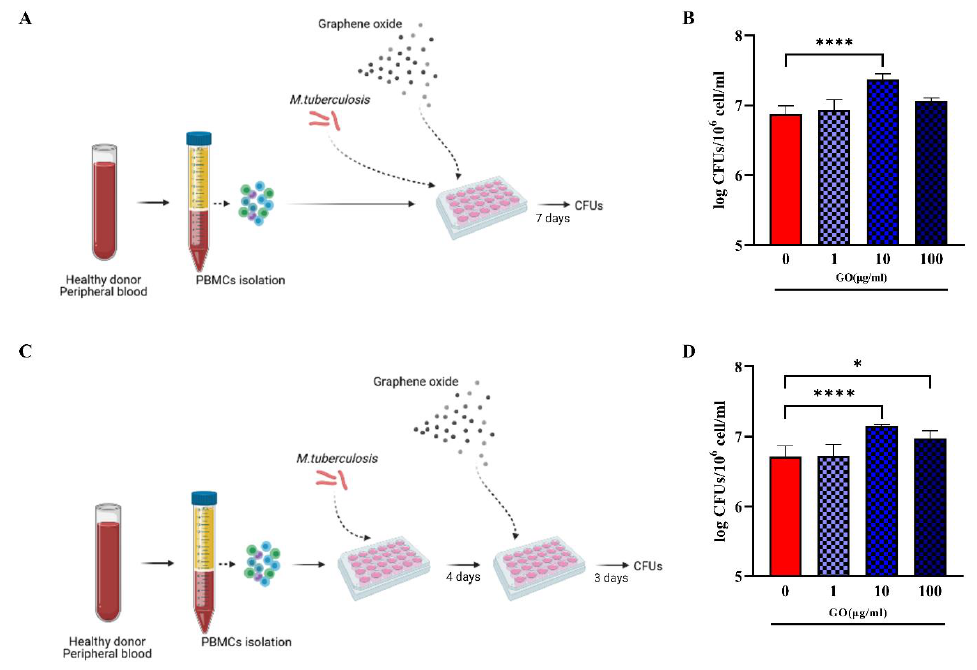
Figure 2. Effect of GO during Mtb ex vivo hPBMCs infection model. To confirm GO